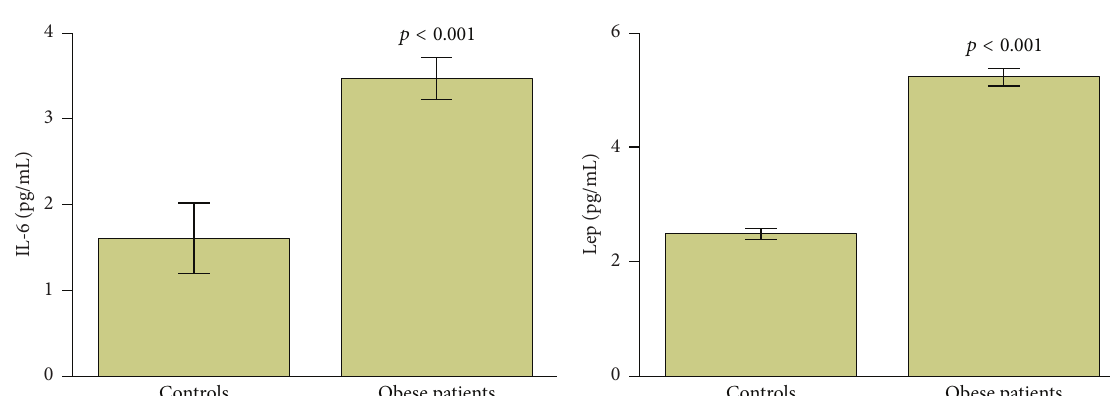
Figure 1: Circulating levels of IL-6 and leptin in obese patients and controls. 𝑝 < 0.05 was considered statistically significant. Data are presented as mean ± standard error. IL: interleukin and Lep: leptin.